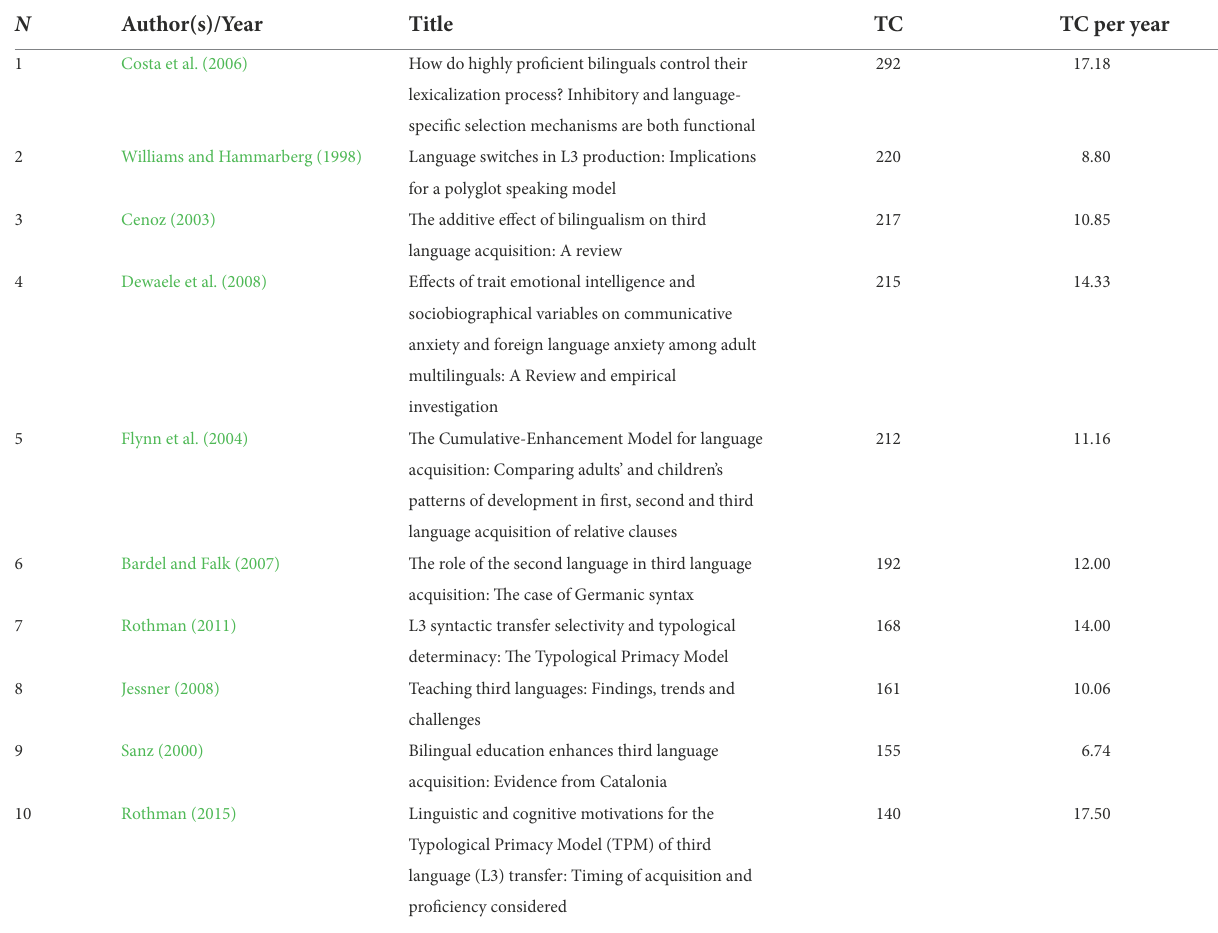
TABLE 3 Top 10 most global cited documents in L3 acquisition from 1984 to